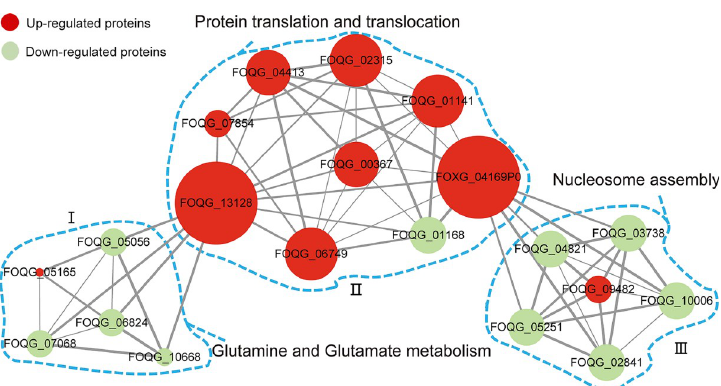
Fig 5. Analysis of protein-protein interaction network for differentially expressed proteins. The nodes represent proteins (down-regulated and up-regulated), and edges represent interaction between proteins. Node size and edge width indicate the number of connected nodes and the strength of interaction, respectively.